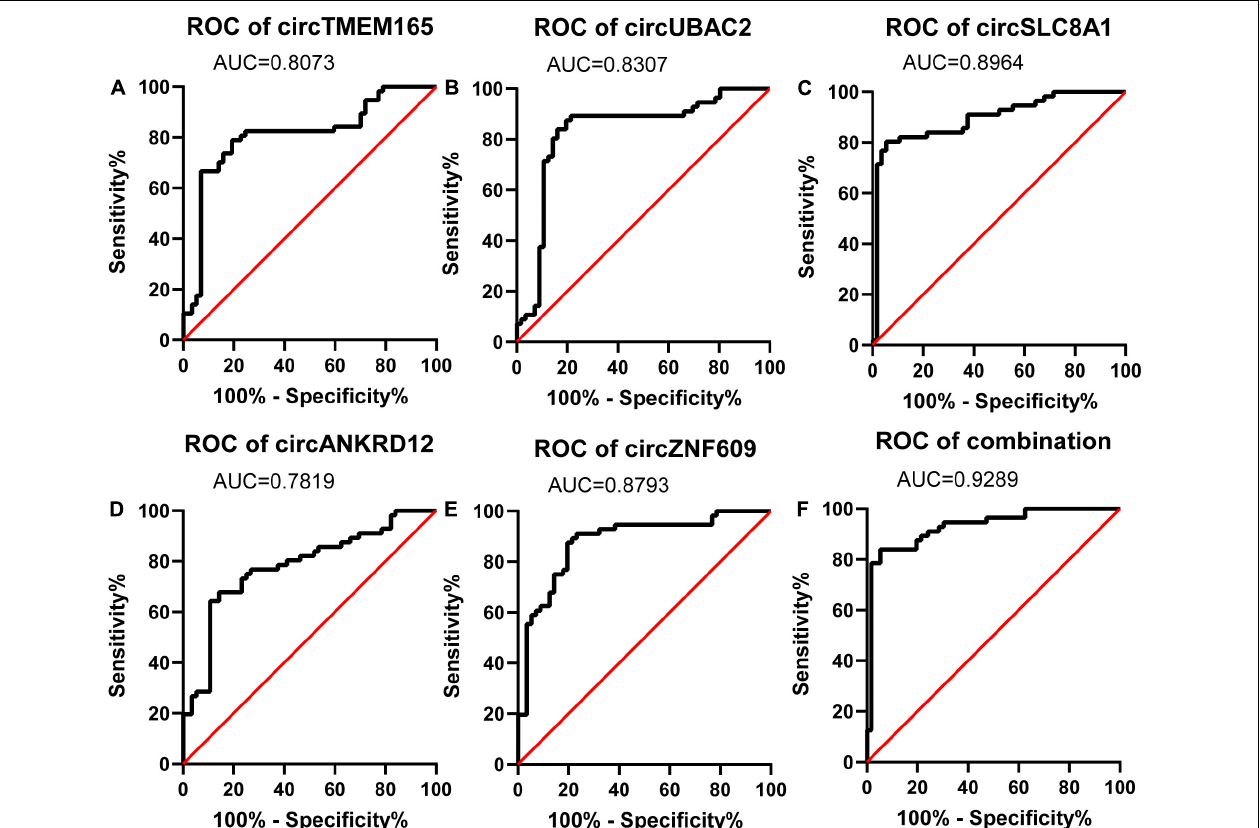
FIGURE 5 | Diagnostic value of circRNAs validated by RT-qPCR. Analysis of the sensitivity and specificity of circRNAs and circRNAs combination as a novel MI marker by ROC curve. (A–E) ROC curves of five RT-qPCR-validated circRNAs. (F) ROC curves of circRNAs combination ( n = 80).